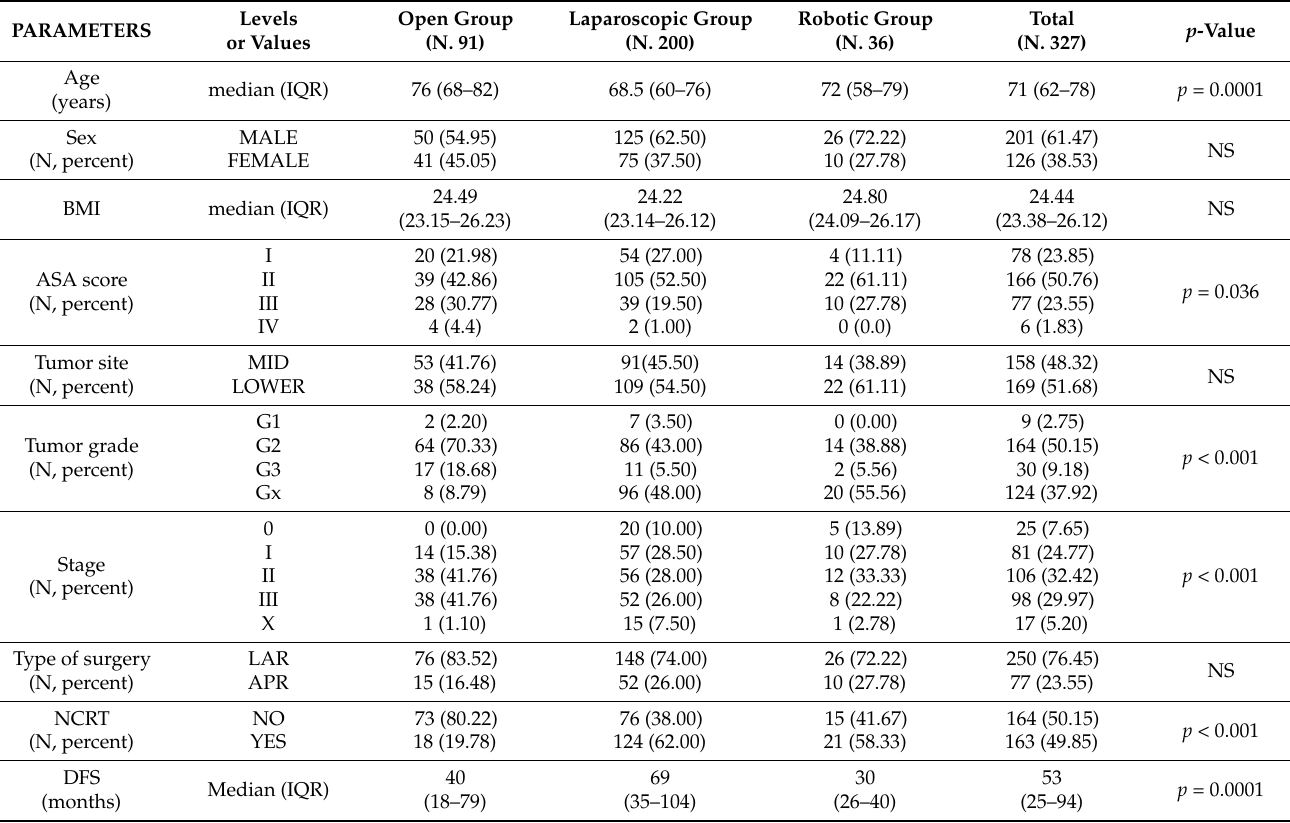
Table 1. Demographic characteristics of the patients enrolled in the present